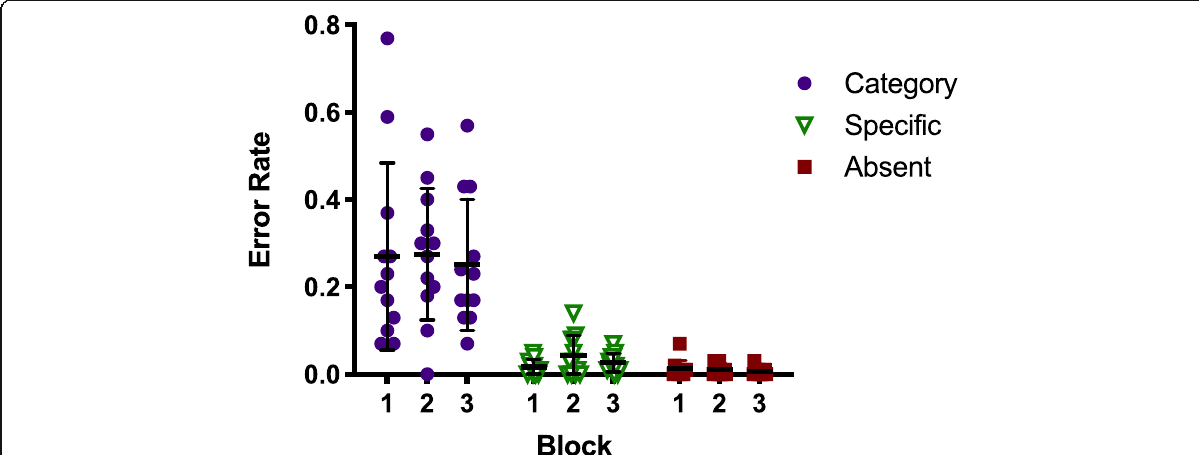
Fig. 5 Error rates for all conditions and all Blocks in Experiment 1b, as a proportion of trials of that type. Error bars represent the standard